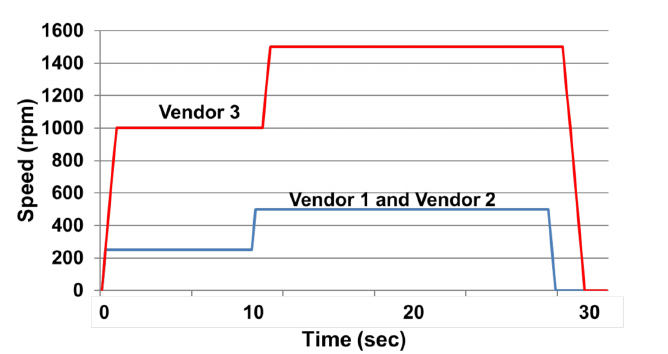
Figure 3. Sample preparation condition for vendors.